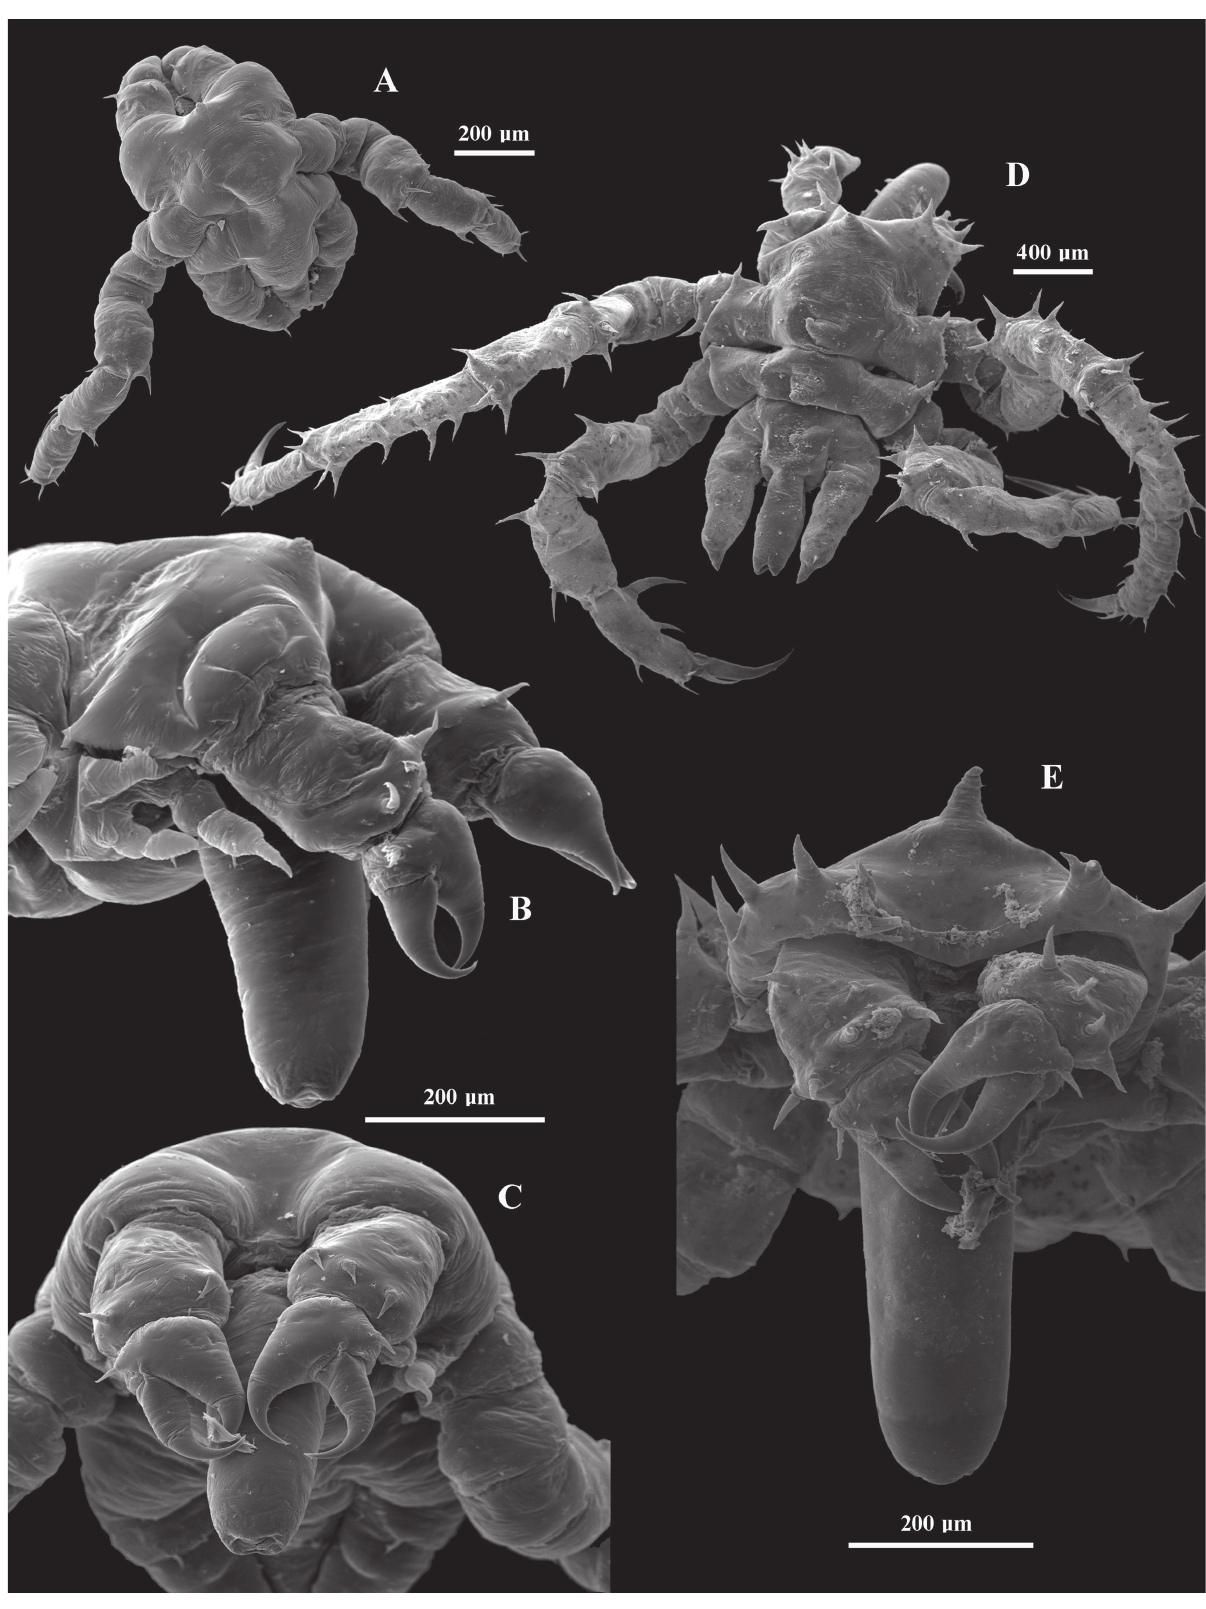
Fig . 5. – larvae of Ammothea glacialis (Hodgson, 1907). sEM photographs: a, third instar larva, dorsal view; b, third instar larva, latero- frontal view; C, third instar larva, frontal view; D, fourth instar larva, dorsal view; E, fourth instar larva, frontal